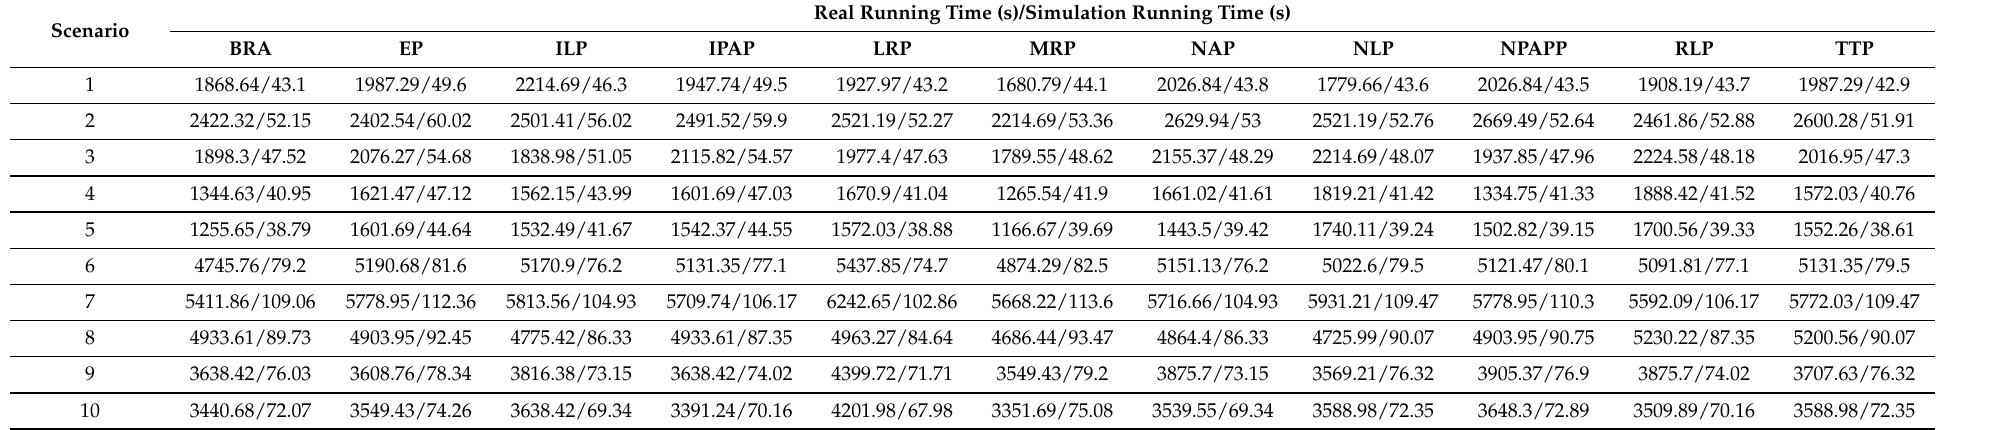
Table 2. Real and simulation running times under TaskQueue workloads and changeable resources.